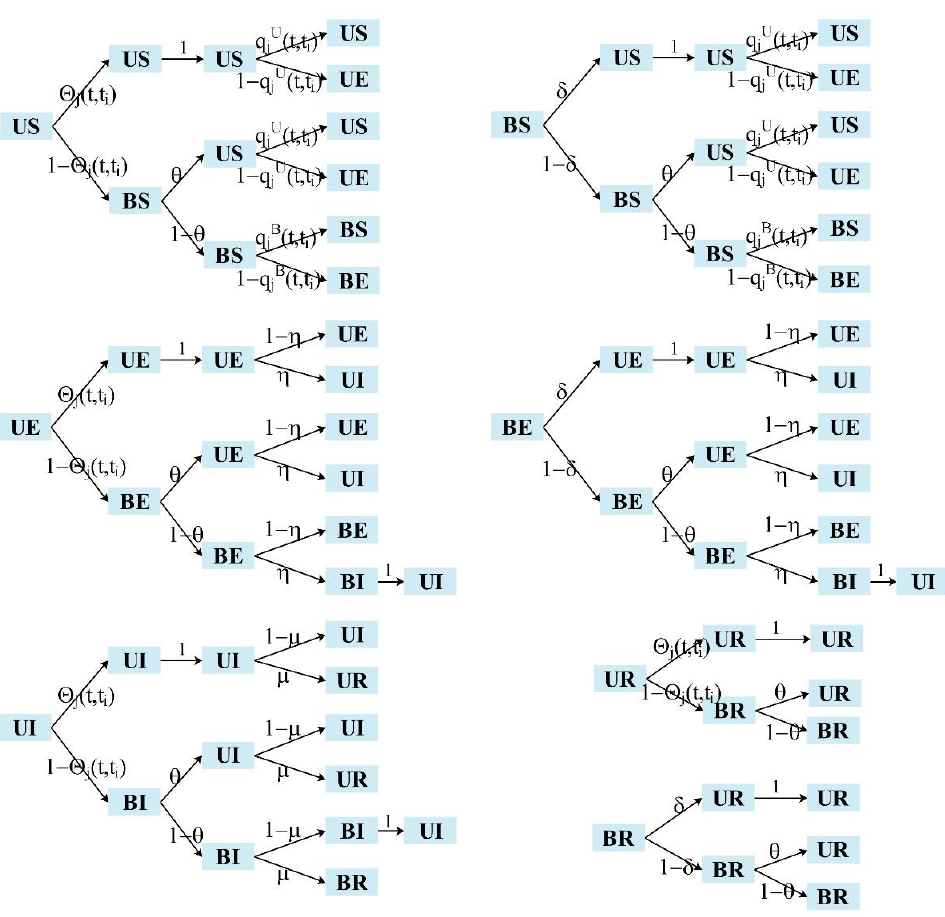
Figure 4. State transition probability tree.